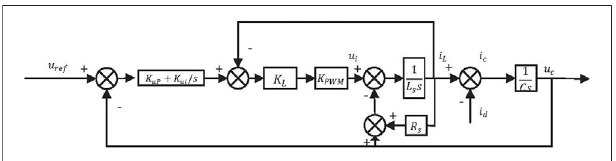
FIGURE 2 | Block diagram of inner voltage regulation loop based on capacitor voltage and inductance current feedback.